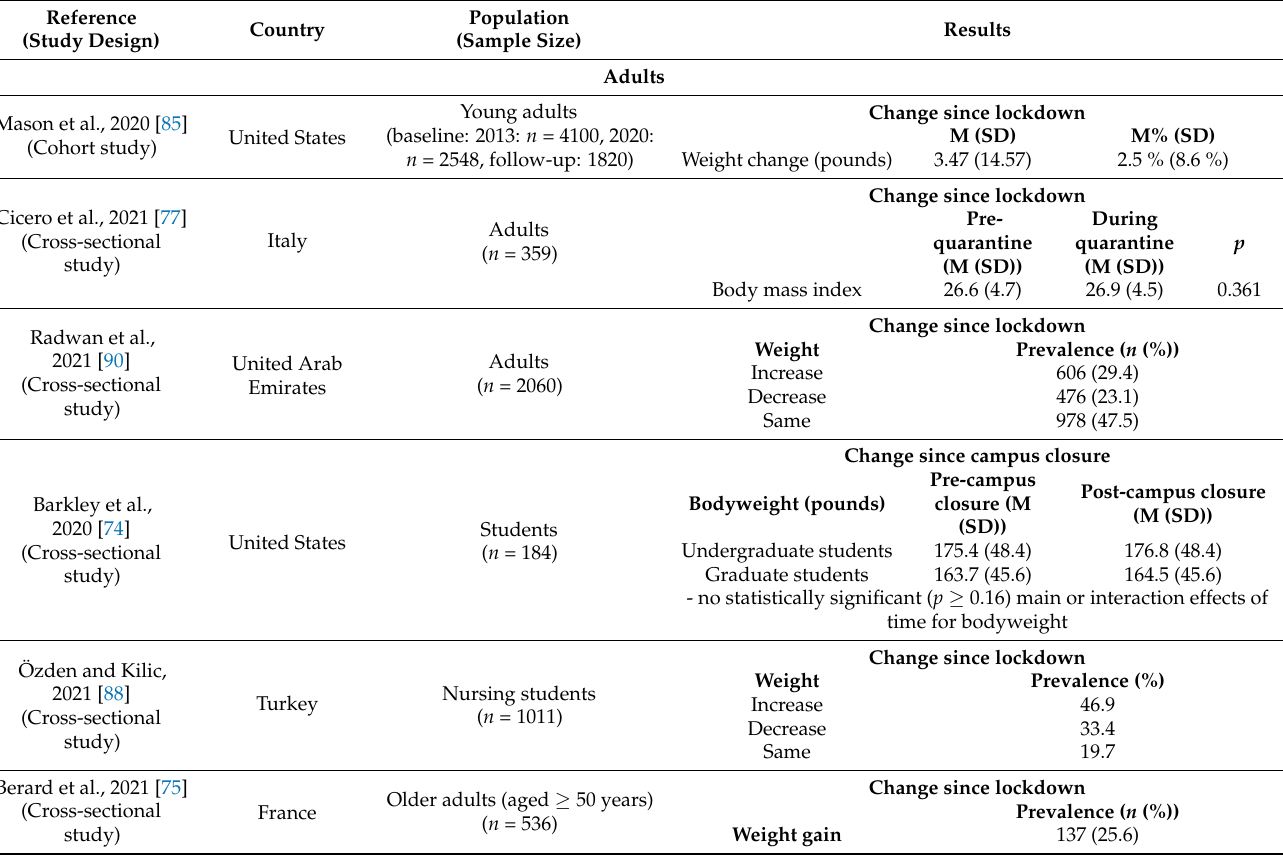
Table 7. Results on weight and body mass